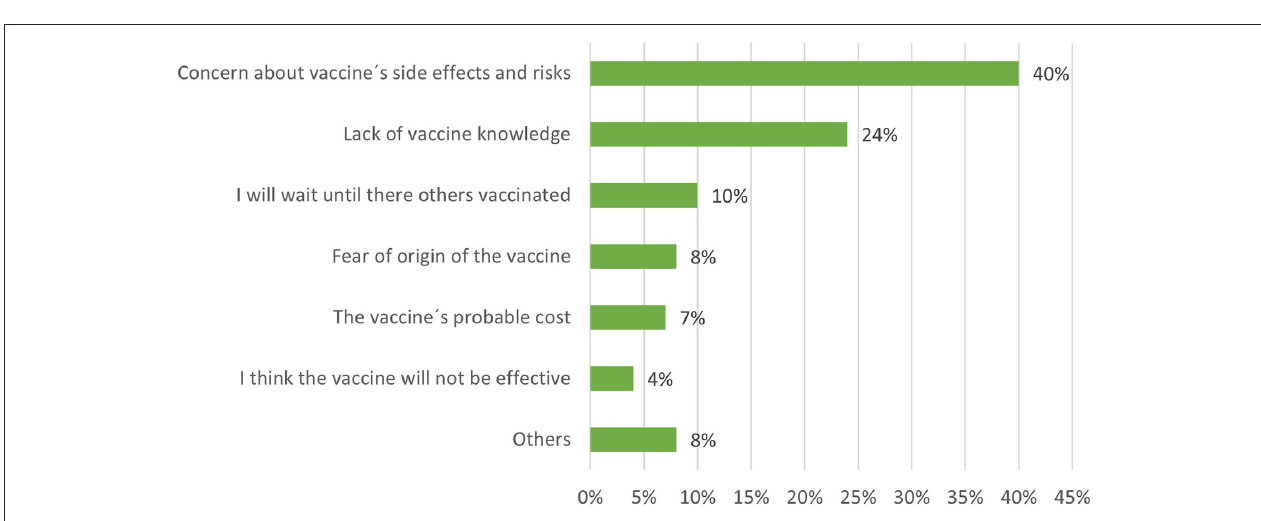
FIGURE 2 | Reasons why respondents may avoid